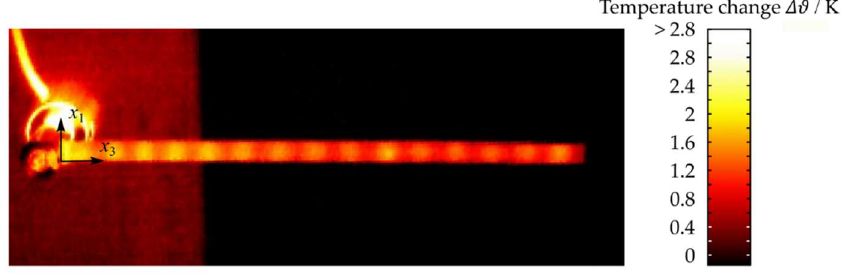
Figure 4. Temperature distribution after a measuring time of 𝑡 = 209 s (tightening torque 𝑀 t = 1.1 Nm, voltage amplitude of the actuator 𝑈(cid:3553) e = 54 V, excitation frequency 𝑓 e = 12.4 kHz)